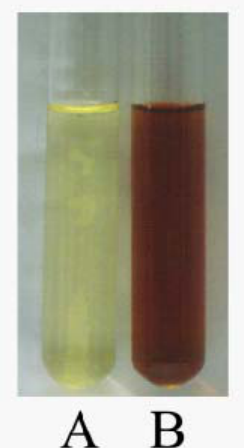
Figure 1. The crude cell filtrate of Aspergillus terreus mixed without AgNO AgNO ( B ) after 24 3